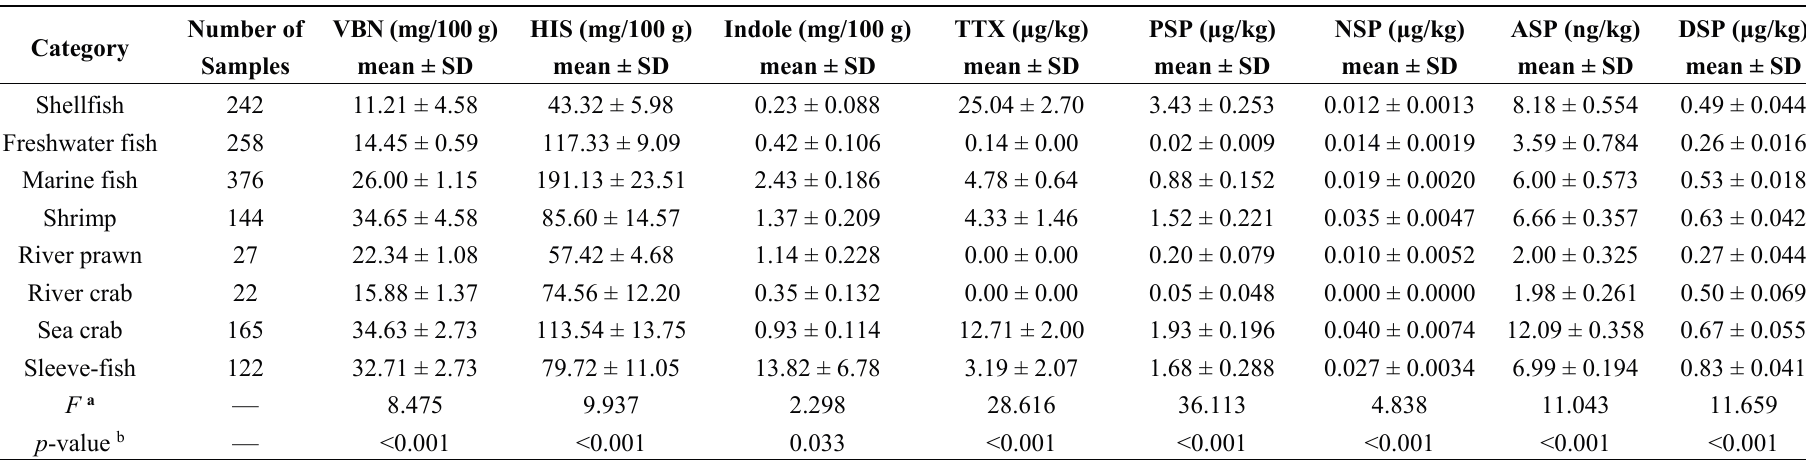
Table 3. Category distribution of the different hygiene index values among the different live fresh aquatic